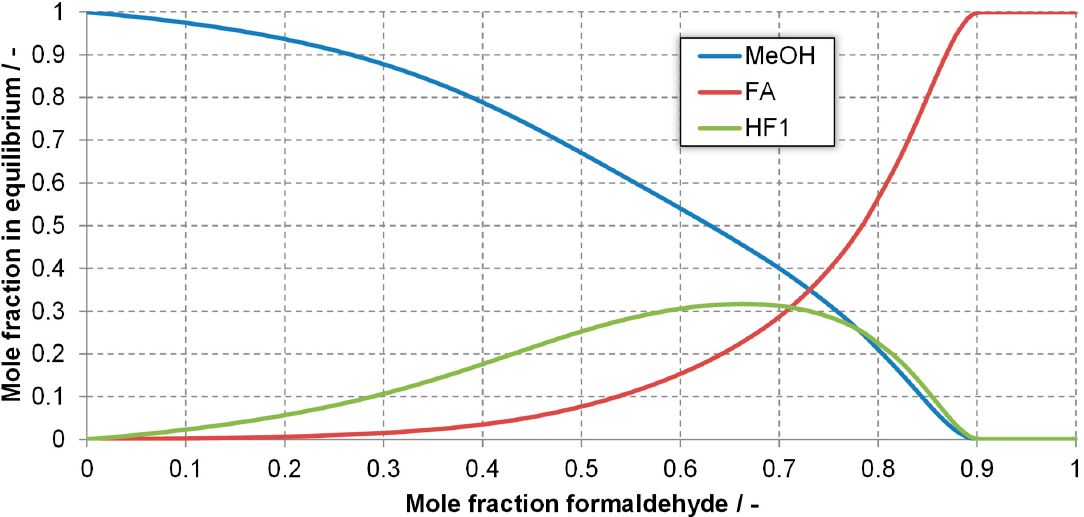
Figure A2. Equilibrium distribution in the gas phase of the component system FA-MeOH at 80 °C.